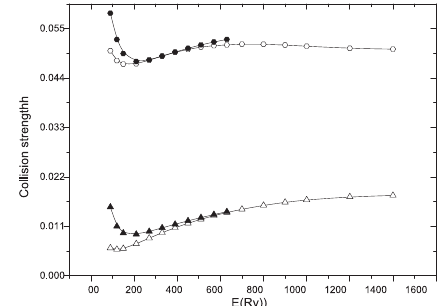
Fig. 2. The present collision strengths (open symbols) as a function of electron energy, compared to R-matrix DARC re- sults (solid symbols) for the two transi- (cid:0) 3 p 2 P o tions: 2 p 2 P o (circles) and 2 p 1 = 2 3 = 2 (cid:0) 4 s 2 S 2 P o 1 = 2 (triangles). 1 = 2